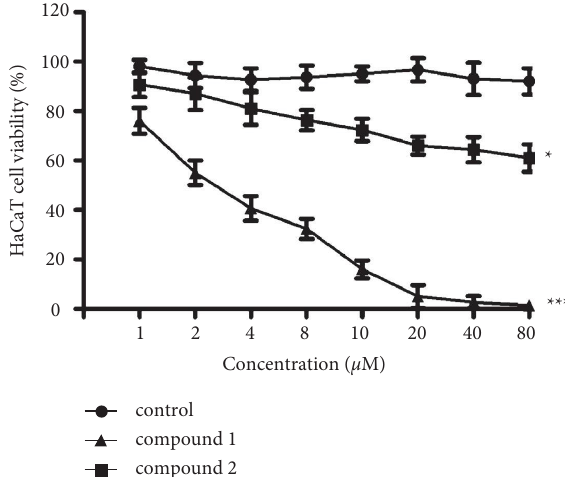
Figure 5: Markedly downregulate the viability of the HaCaTcells after treatment of as-created compound. The complexes were employed for treating HaCaTcell with various dilutions. The HaCaTcells viability was measured through CCK-8 detection. ∗ means P < 0 . 05 and ∗∗∗ means P < 0 . 005. Compound inhibited the activation of the VEGF signal pathway in the HaCaT cells.